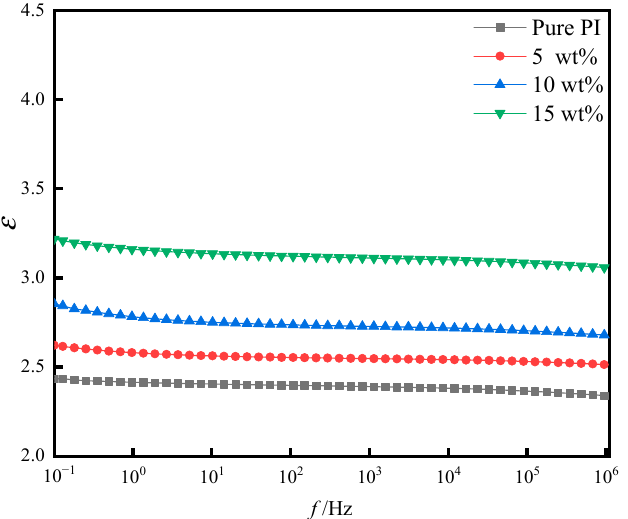
Figure 9. Dielectric constant of pure PI film and different doping amounts of PI/SiO 2 composite films with frequency.